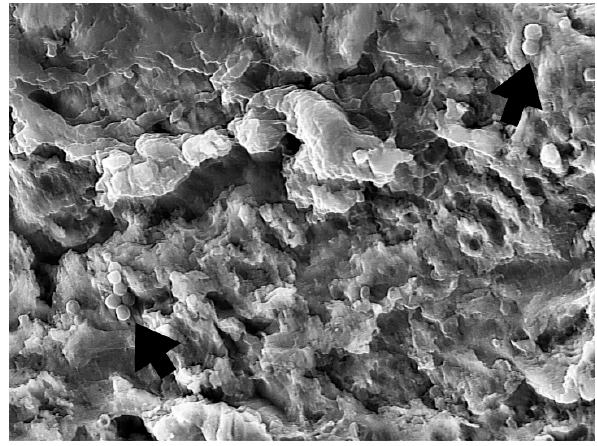
Figure 9. PC group—bacterial and fungi biofilm reduction after 0.2% CHX treatment (5000 × ). Microorganism cells can still be observed (arrow).